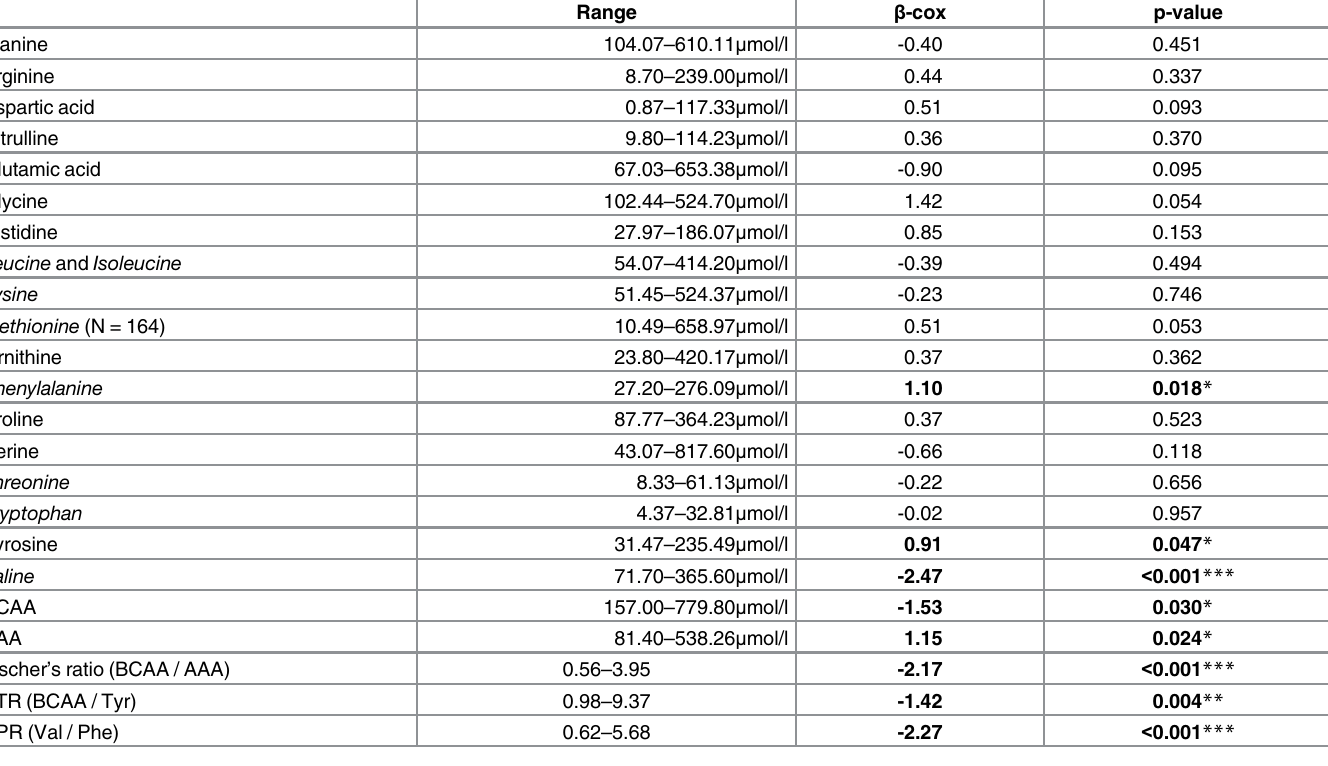
Table 3. Data of the measured metabolite panel (N = 166). Survival analysis was performed by an univariate cox-regression model. Significant results are written in bold and asterisked ( * , ** , *** ). Essential amino acids are printed in italics. Range β -cox p-value 104.07 – 610.11 μ